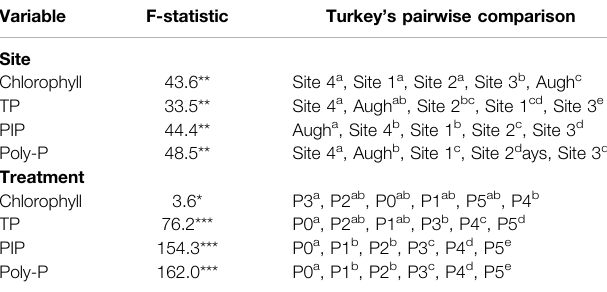
TABLE 2 | Blocked one-way ANOVA and corresponding Tukey ’ s HSD pairwise comparisons for fi xed site and treatment effects. Sites and treatments are listed in order of their means (low to high), with superscripts indicating which variablesarestatisticallydifferentfromeachother(Tukey ’ scomparisons p < 0.05).